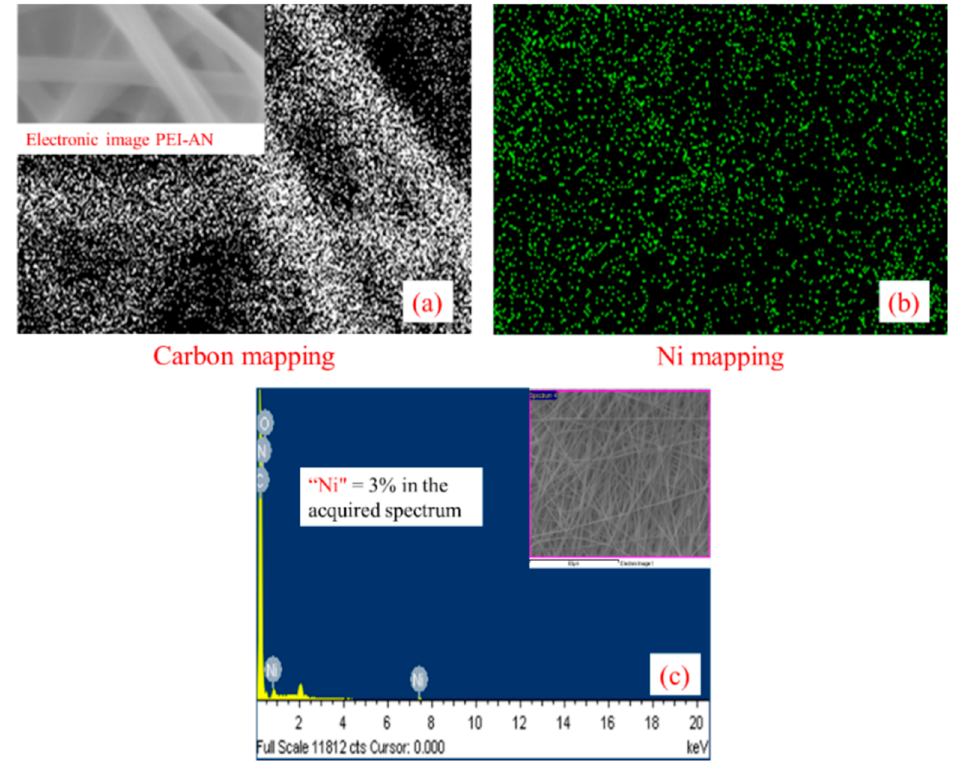
Figure 7. ( a , b ) EDX mapping and ( c ) EDX spectra of PEI-AN after Ni 2 +